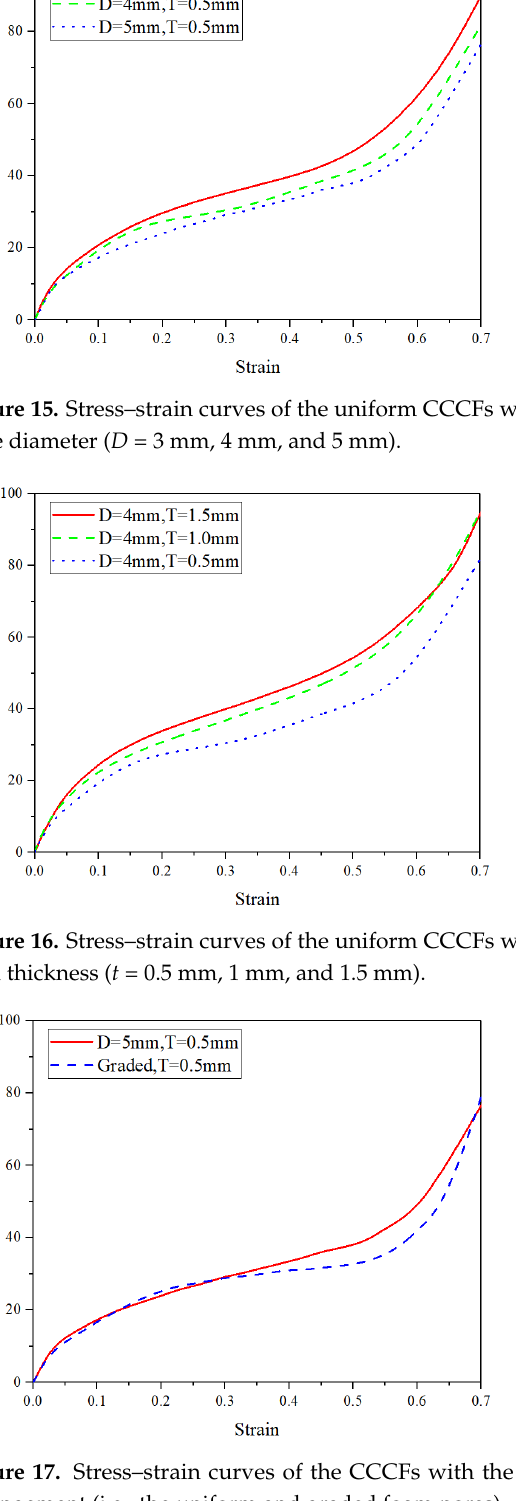
Figure 17. Stress–strain curves of the CCCFs with the same wall thickness and a different pore ar- rangement (i.e., the uniform and graded foam pores).